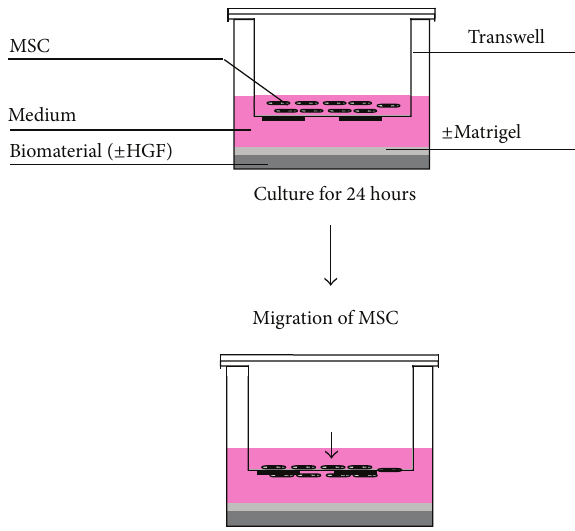
Figure 7: Sketch of modified Boyden chamber